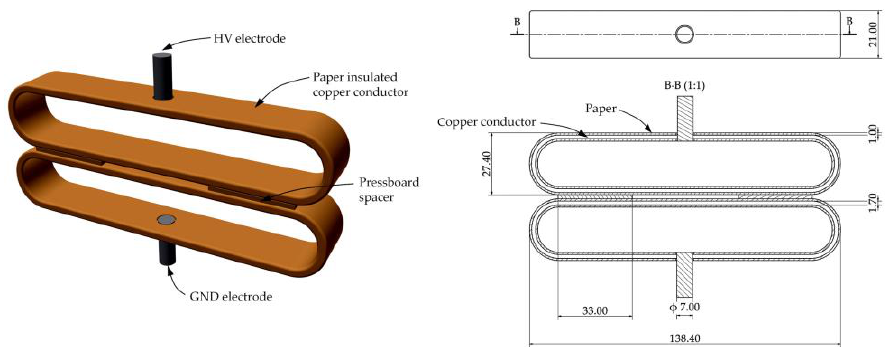
Figure 7. Pictures presenting consequences of destructive action of interturn discharges: ( a ) breakdown of paper insulation in the place of the deformed winding, ( b ) a vast area of carbonized winding insulation, (c) complete destruction of windings and insulation.